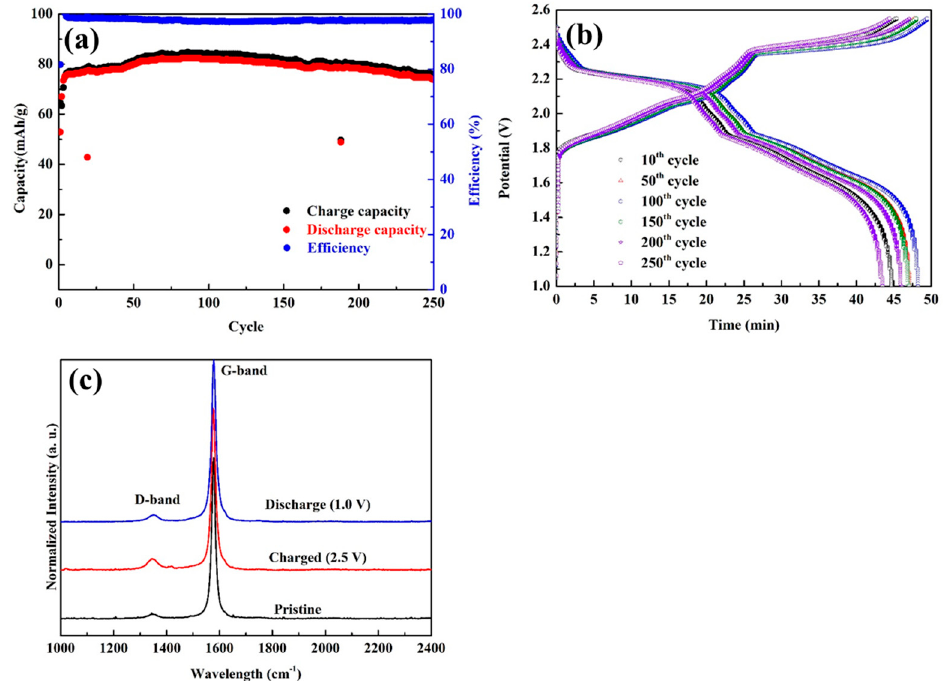
Figure 6. Electrochemical properties of the 10 mg/cm 2 graphite electrode at 100 mA/g: ( a ) long-term stability test; ( b ) discharge–charge curves at constant current of 100 mA/g (1C); ( c ) Raman spectra for pristine, fully charged, and discharged graphite